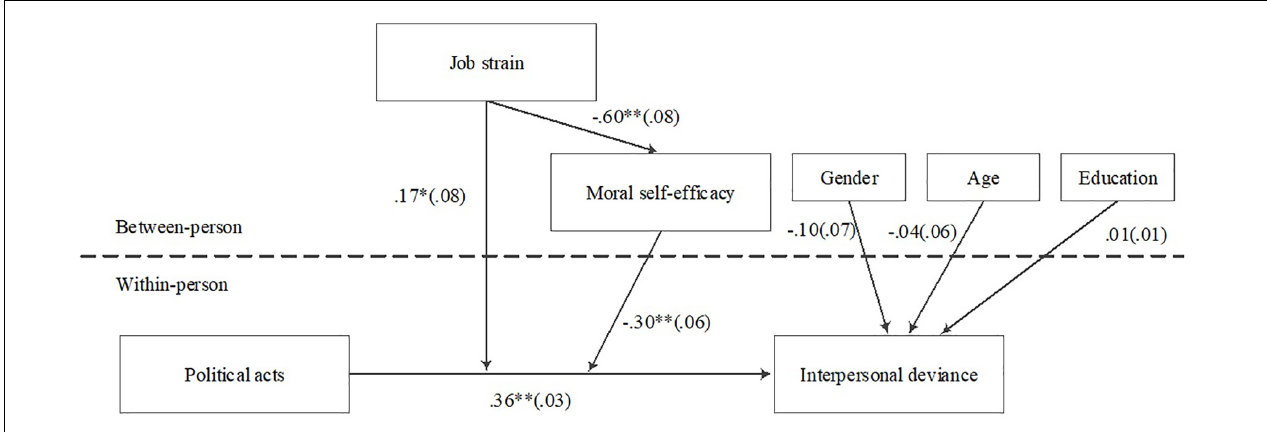
FIGURE 1 | Conceptual model and results of structural equation model. N = 760 at the within-person level; N = 152 at the between person level. ∗ p < 0.05; ∗∗ p <